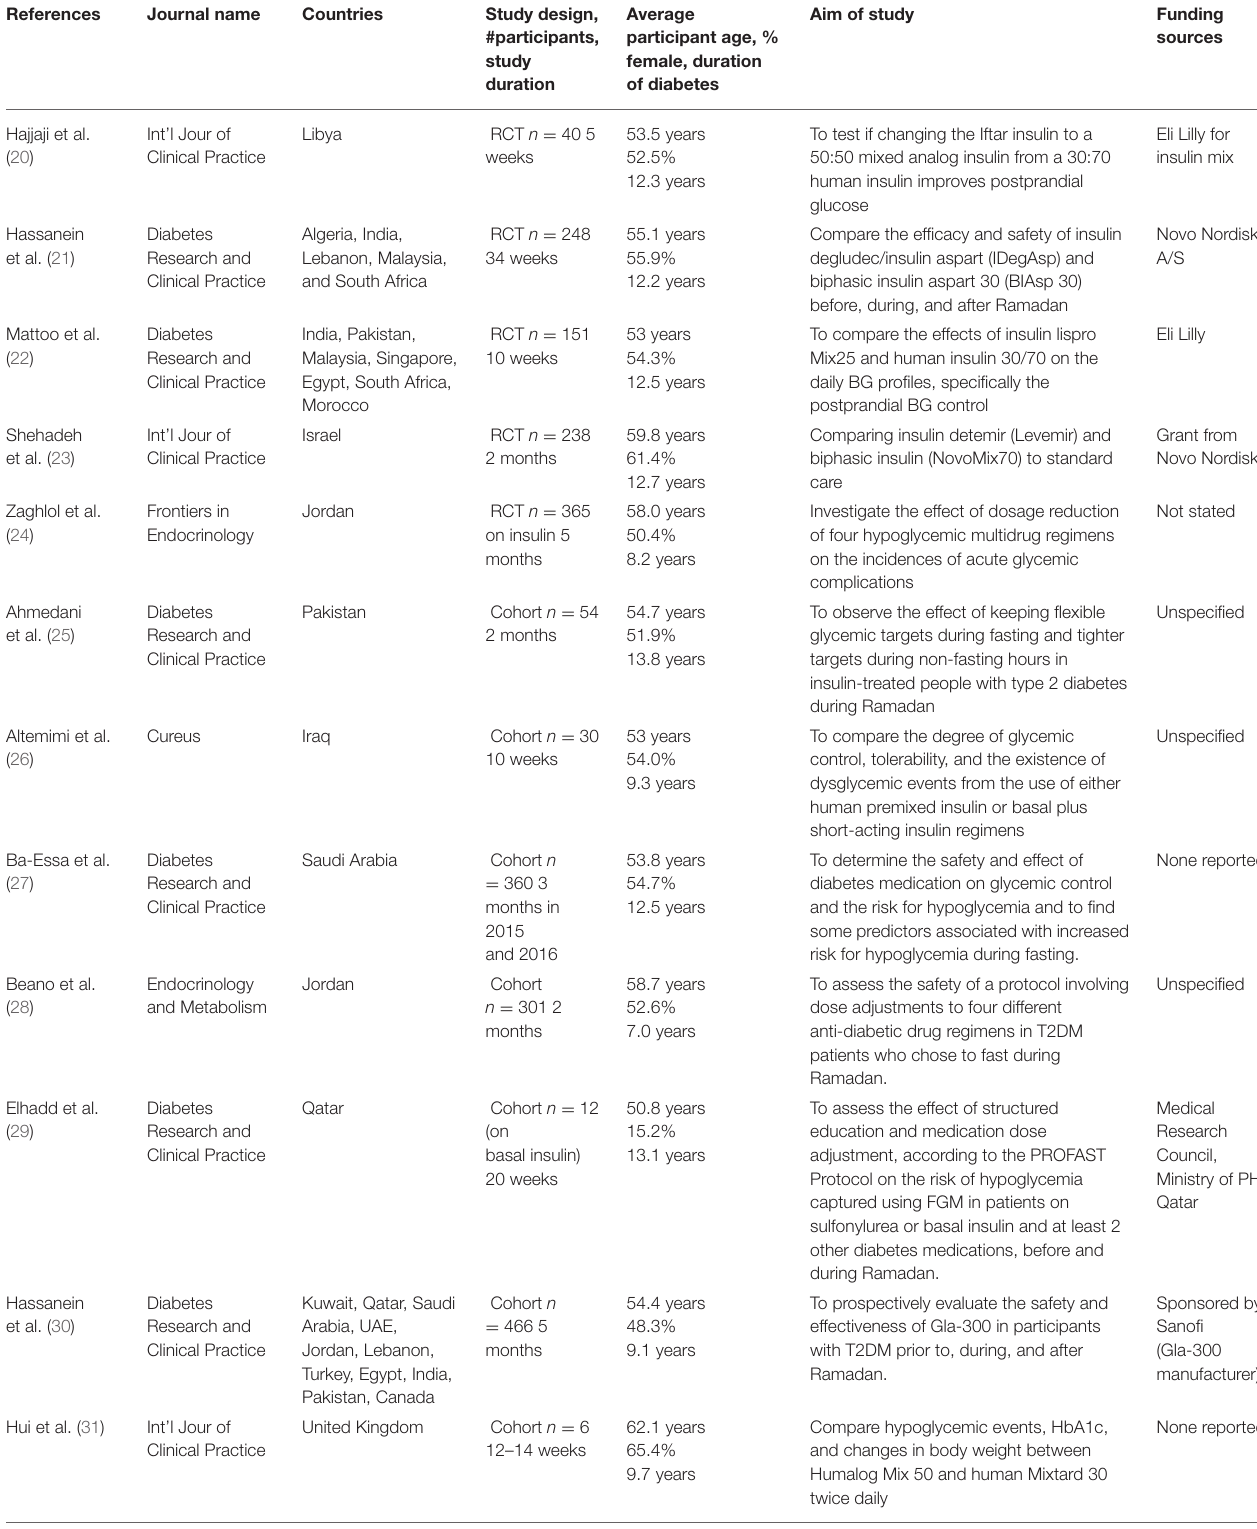
TABLE 2 | Comprehensive summary of included